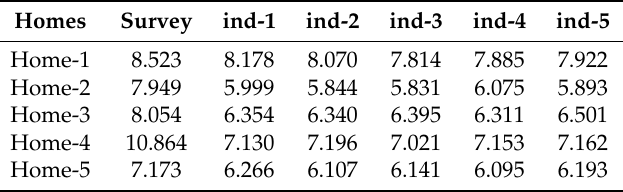
Table 7. Survey and indicator results for the smart homes.